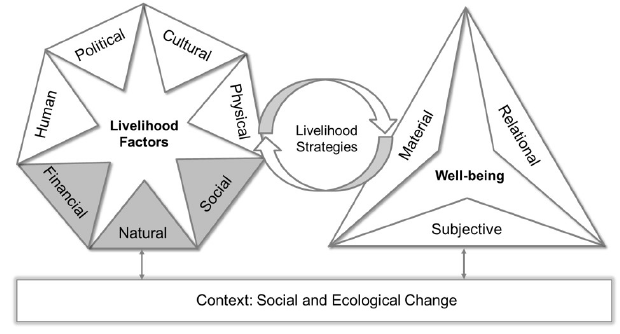
Fig. 3 . The integrated sustainable livelihoods approach and well-being framework for northeastern Colorado livestock producers. Within the context of rapid social and ecological change, livestock producers interrelate these seven livelihood factors, i.e., financial, natural, social, human, physical, political, and cultural, to create strategies to sustain or improve their material, relational, and subjective well-being. Financial, natural, and social factors are represented in grey as foundational factors or those essential to how producers conceptualize their livelihoods. Feedback between well-being outcomes and livelihood factors facilitate cycles of accumulation, sustaining, or